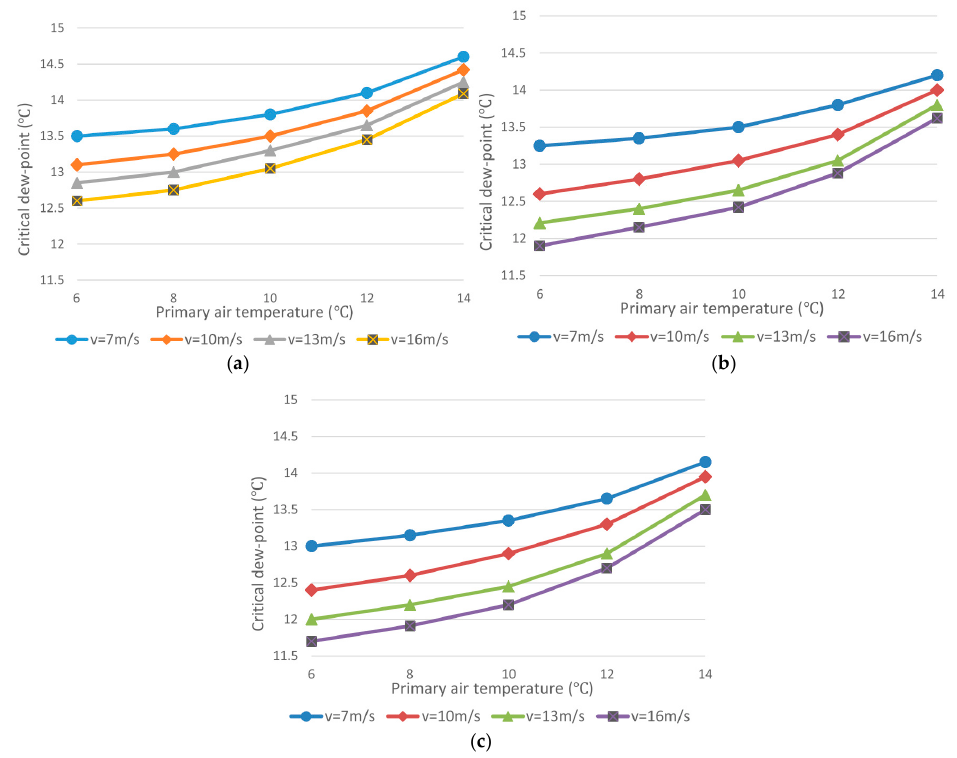
Figure 3. The primary air temperature and the critical dew-point temperature: ( a ) H = 3%; ( b ) H = 6%; and ( c ) H = 9%. and ( c ) H =